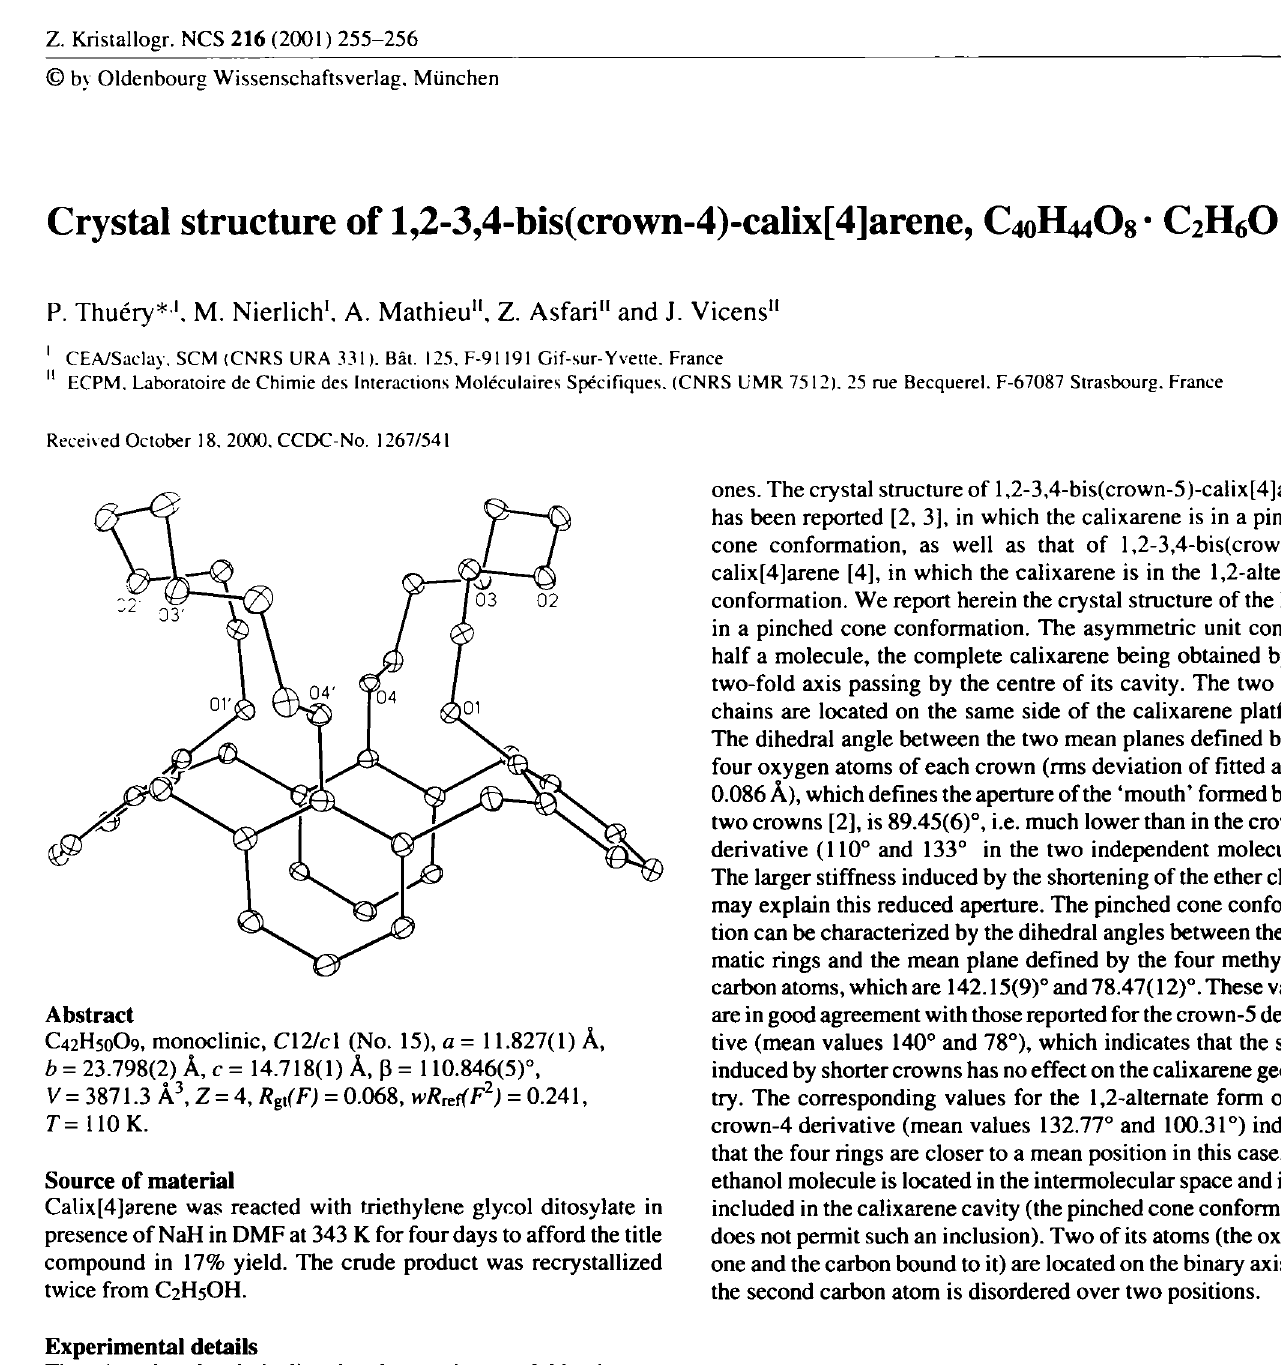
Table 1. Data collection and